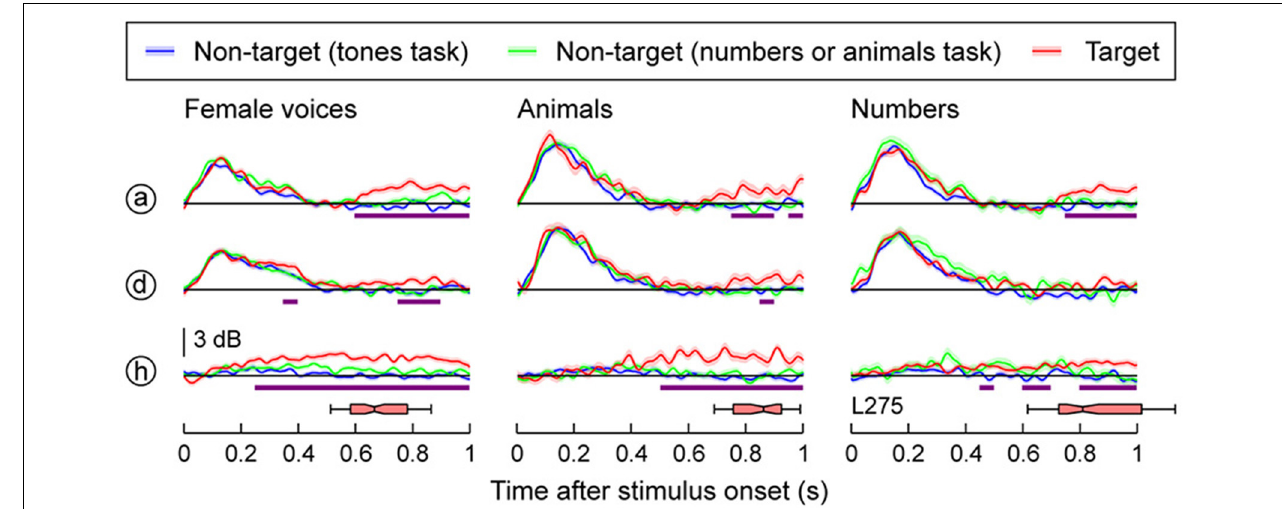
FIGURE 2 | Task effects on responses to speech stimuli in HG. Responses to three types of stimuli (female voices, animals, numbers; left, middle and right column, respectively) are shown for three representative recording sites in HG (rows). See Figure 1A for location of the recording sites. Colors (blue, green, and red) represent different task conditions. Lines and shaded areas